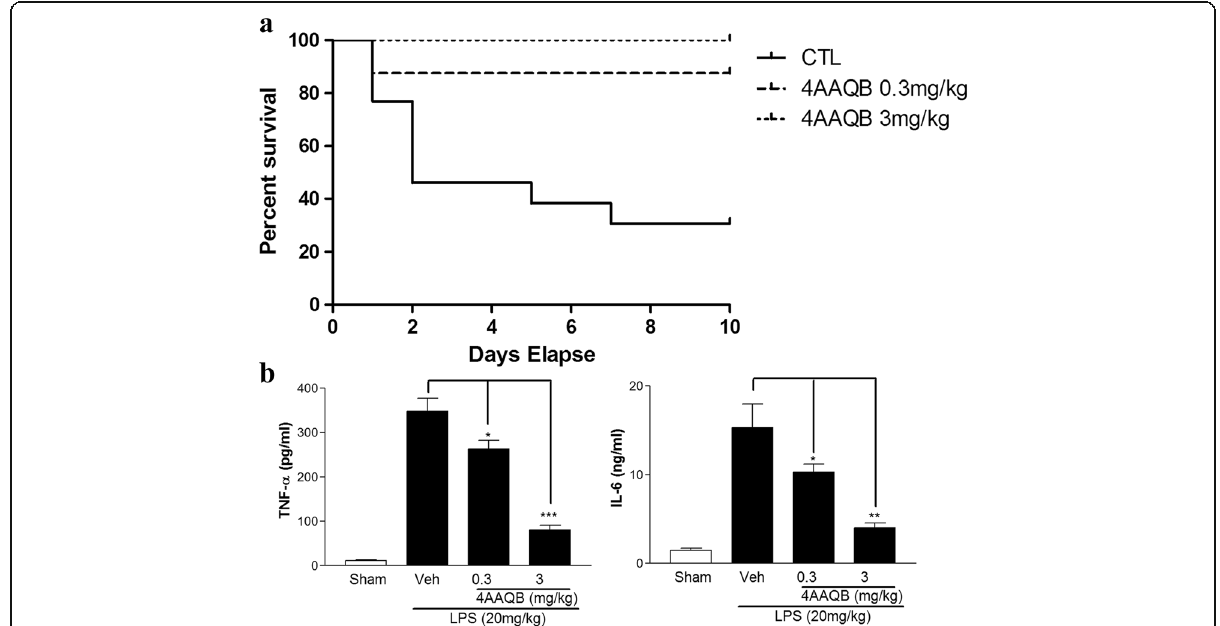
Fig. 7 The protective effects of 4AAQB on survival rate, cytokine production and tissue inflammation induced by CLP operation in vivo. Mice were administered with 4AAQB (0.3 and 3 mg/kg, i.p., n =8) in DMSO or DMSO (CTL, n =13) for 30 min, and then conducted CLP operation. a Survival was monitored for up to 10 days. Values are presented as mean+S.E.M. *p<0.05 as compared with the LPS-activated group. b Mice were anesthetized and blood was collected for serum isolation 24 h after CLP operation, and concentration of cytokines was measured by ELISA. Values are presented